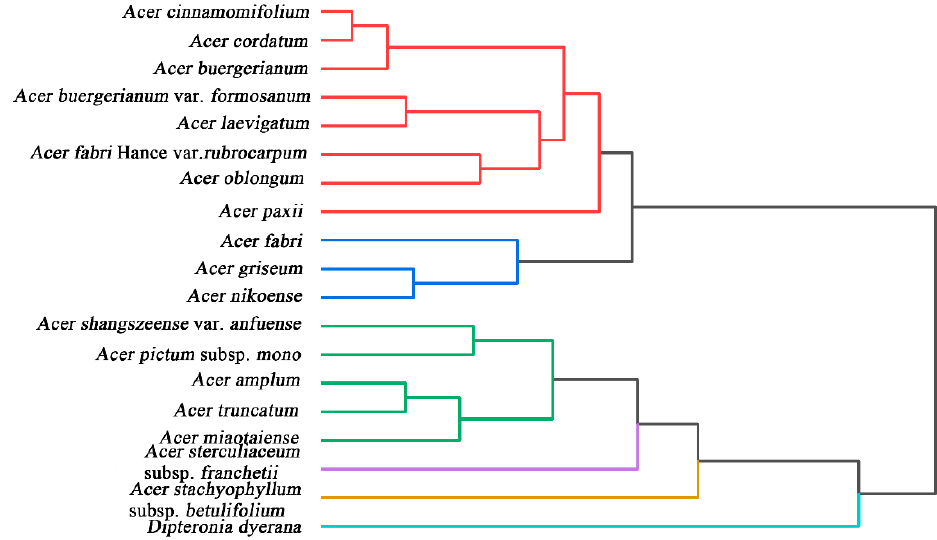
Figure 4. Dendrogram of A. shangszeense var. anfuense, A. pictum subsp. mono, A. amplum, A. truncatum, A. miaotaiense, A. nikoense, A. griseum, A. fabri Hance var. rubrocarpum, A. paxii, A. oblongum, A. laevigatum, A. buergerianum var. formosanum, A. cinnamomifolium, A. buergerianum, A. cordatum, A. fabri, A. sterculiaceum subsp. Franchetii, A. stachyophyllum subsp. betulifolium, and Dipteronia dyerana based on electrochemical fingerprints.